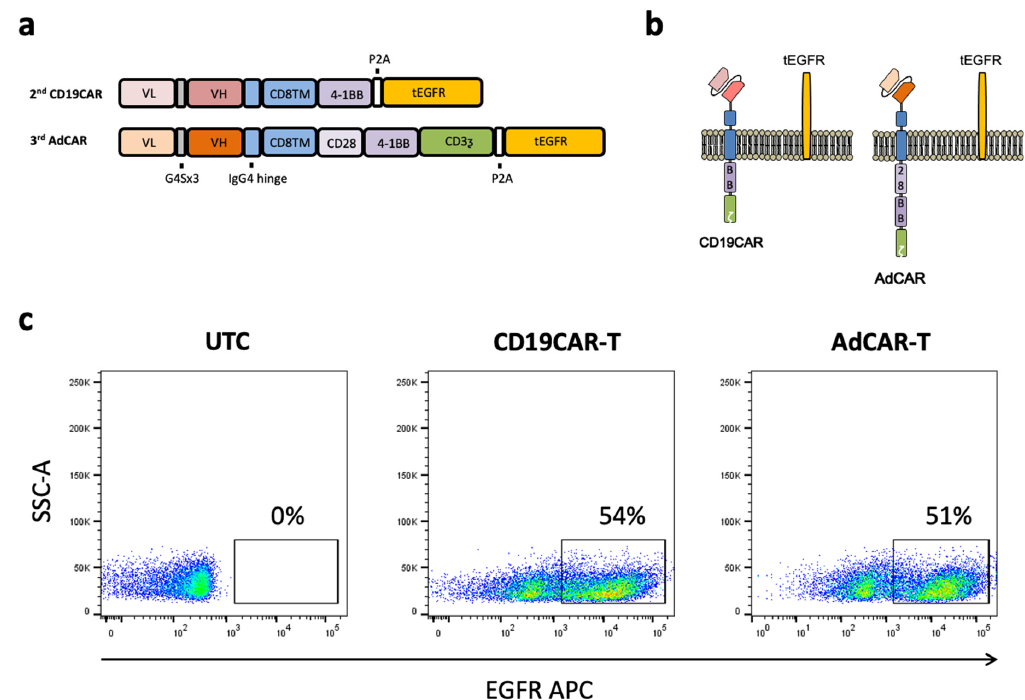
Figure 1. Design and expression profile of second-generation CD19CAR and third-generation AdCAR T cells. ( a ) Illustration of the transgene design of the conventional second-generation CD19CAR and the third-generation AdCAR including the marker gene. ( b ) Schematic illustration of the transgene CAR and marker gene expression in the context of the cell membrane. ( c ) The expression of CAR was determined by flow cytometry utilizing the co-expressed marker gene tEGFR. Representative flow cytometric plots for non-transduced activated T cells (left), CD19CAR T cells (middle), and AdCAR T cells (right) are shown.